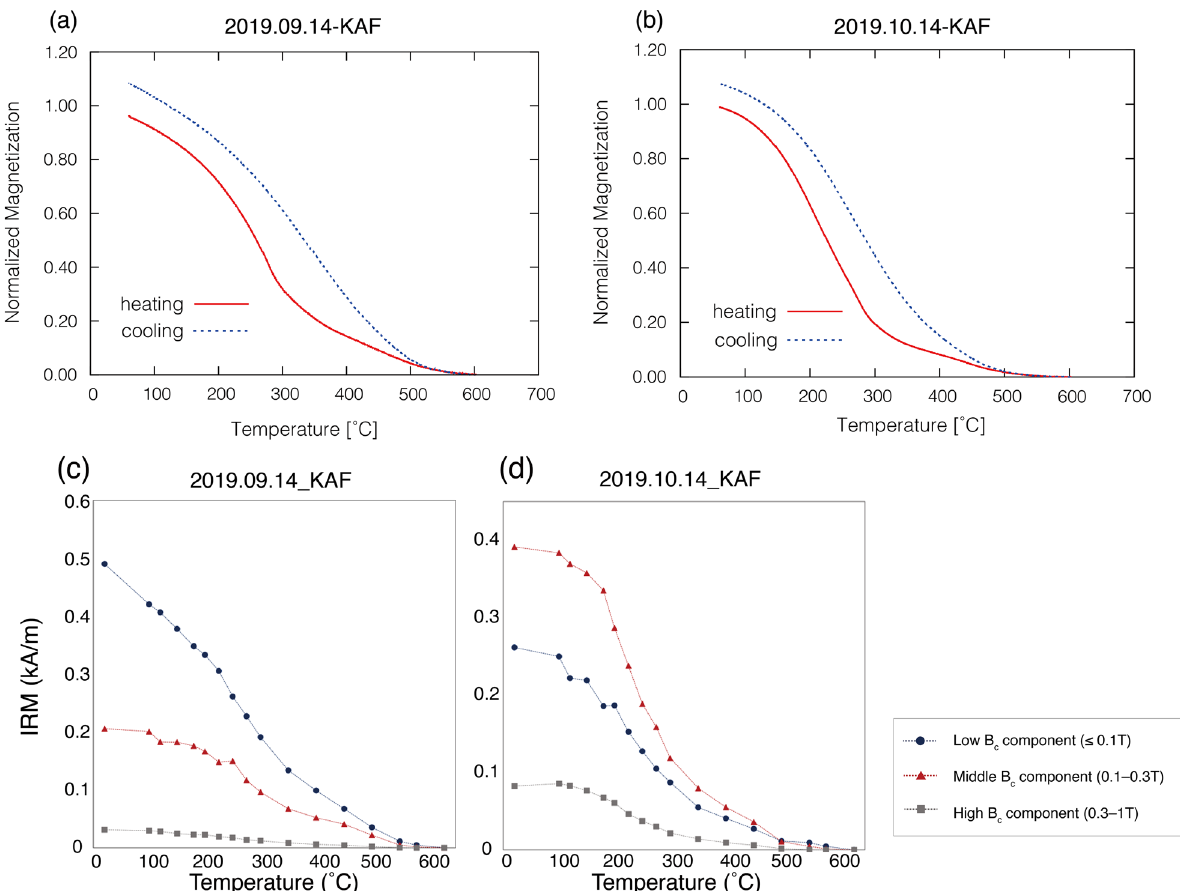
Fig. 1 Results of thermomagnetic analyses and thermal demagnetizations of a 3-axis composite IRM. a Thermomagnetic analysis in air for the sample of September 14, 2019. The red solid line is the heating curve and the blue dashed line is the cooling curve. b Result of thermomagnetic analyses in air for the sample of October 14, 2019. Legend is the same as a . c Result of thermal demagnetization of a 3-axis composite IRM for the sample of September 14, 2019. Coercivity components of 0.1 T, 0.1–0.3 T, and 0.3–1 T are shown by circles, triangles, and squares, respectively. d ≤ Result of thermal demagnetization of a 3-axis composite IRM for the sample of October 14,